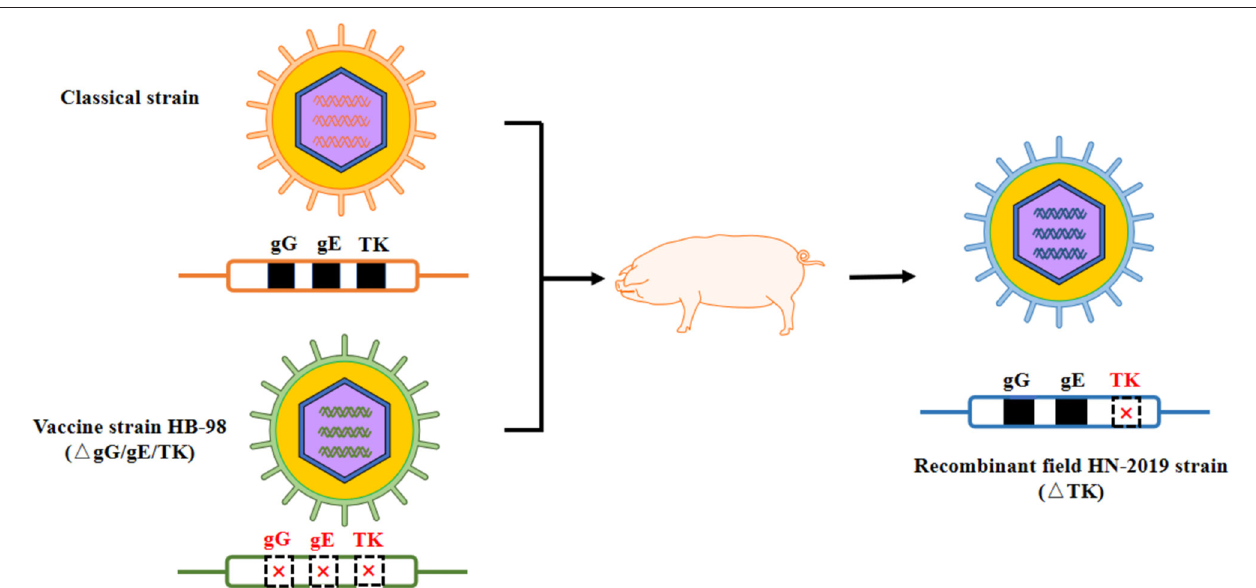
FIGURE 4 | Proposed model of genomic recombination of HN-2019 strain. HB-98-vaccinated pigs were infected with classical PRV strain. During the replication of two PRV strains in pigs, HN-2019 with TK gene deletion was